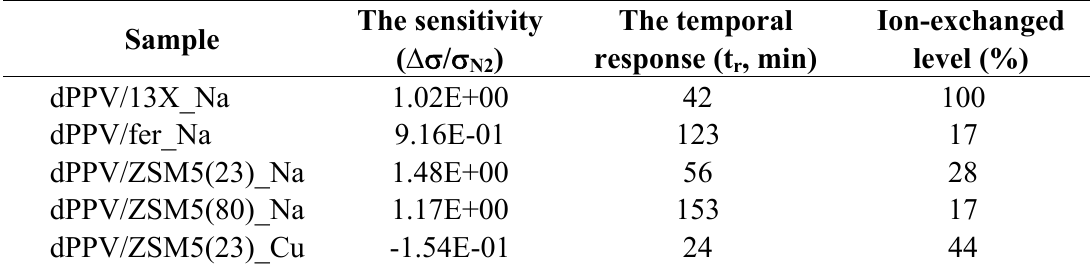
Table 3. Electrical conductivity sensitivities, temporal responses, and ion-exchange levels of PPV/Zeolite